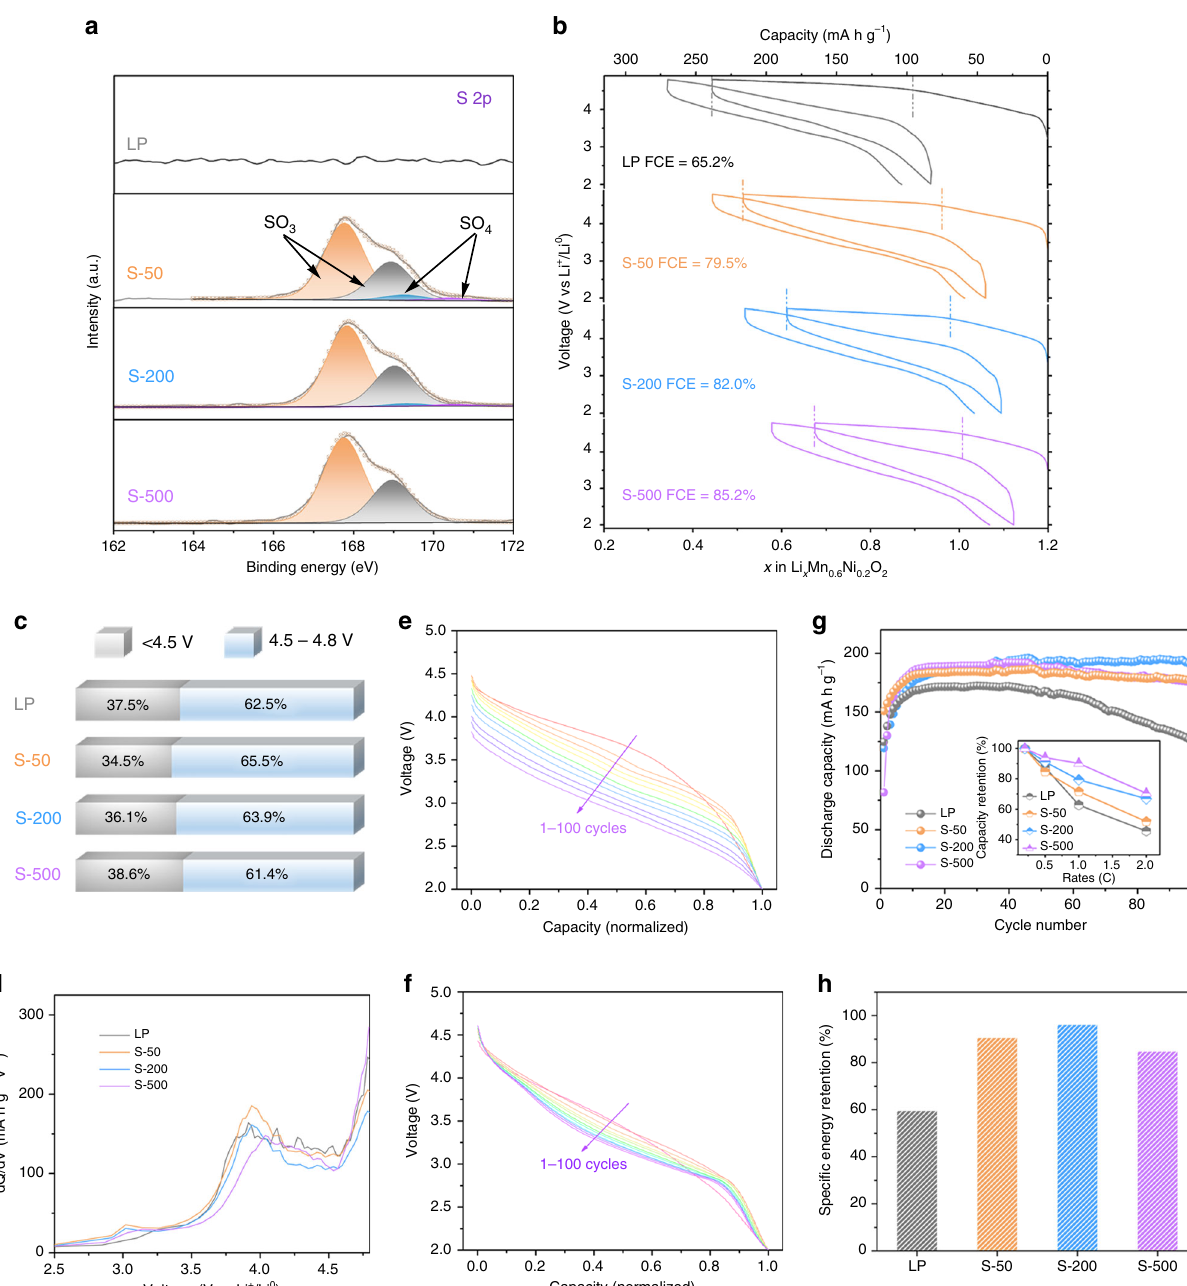
Fig. 5 The surface states and electrochemical behavior of products before and after S deposition. a S 2 p spectra of products before and after S deposition. b Voltage pro fi les of the fi rst two cycles obtained at 0.5 C. Regions from 4.5 to 4.8 V are marked with vertical dash lines. c Percentage-stacked bar chart of charge capacities in the fi rst cycle obtained at 0.5 C; the total capacities are divided into two sections: <4.5 V and 4.5 – 4.8 V. d dQ/dV curves of the charge process in the second cycle obtained at 0.5 C. e Normalized galvanostatic discharge pro fi les of LP obtained at 1 C. f Normalized galvanostatic discharge pro fi les of S-200 obtained at 1 C. g Cyclic performance at 1 C together with the capacity retention at different rates (insets). h Speci fi c energy- density retention after 100 cycles at 1 C. state. In contrast to the layered con fi guration in the interior primarily composed of a cation-disordered rock-salt structure (Fig. 6g), the outmost region appears to be a LiMn 2 O 4 -type spinel (Supplementary Fig. 12d – f). This difference is in agreement with structure with a three-dimensional framework constructed by the ex situ XRD measurement (Supplementary Fig. 13), which MO 6 octahedra (Fig. 6i, j). Note that this LiMn 2 O 4 -type layer is shows a well-preserved phase constitution in cycled S-200, but a different from the Mn 3 O 4 -type structure seen before cycling, as much more secondary phase in the cycled LP. In addition, the the TM ions are located in octahedral sites. Such a structural cycled LP showed an amorphous feature layer with a thickness of evolution is likely from the further rearrangements of surface 3 – 4 nm, which is more likely associated with the loss of atomic con fi gurations upon charging/discharging. However, for crystallinity after accumulated oxygen loss, rearrangement of the cycled LP electrode, the atomic con fi guration appears to be transition-metal ions, and the corrosion of the electrolyte 56 – 60 . NATURE COMMUNICATIONS| (2020) 11:3411